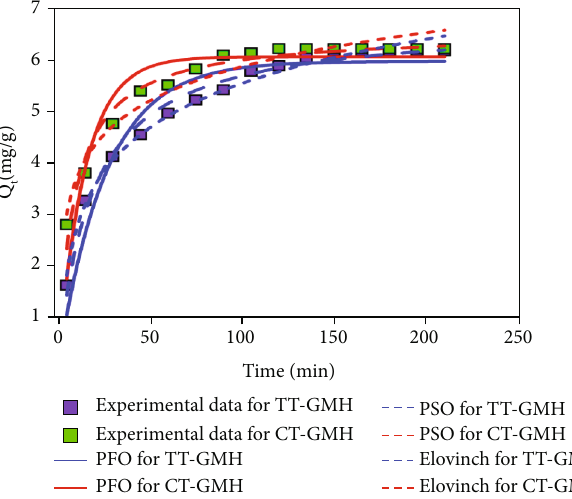
Figure 6: Nonlinear kinetic modeling for both the adsorbents. Table 2: Kinetic parameters for adsorption of Cr(VI) onto TT-GMH and CT-GMH.